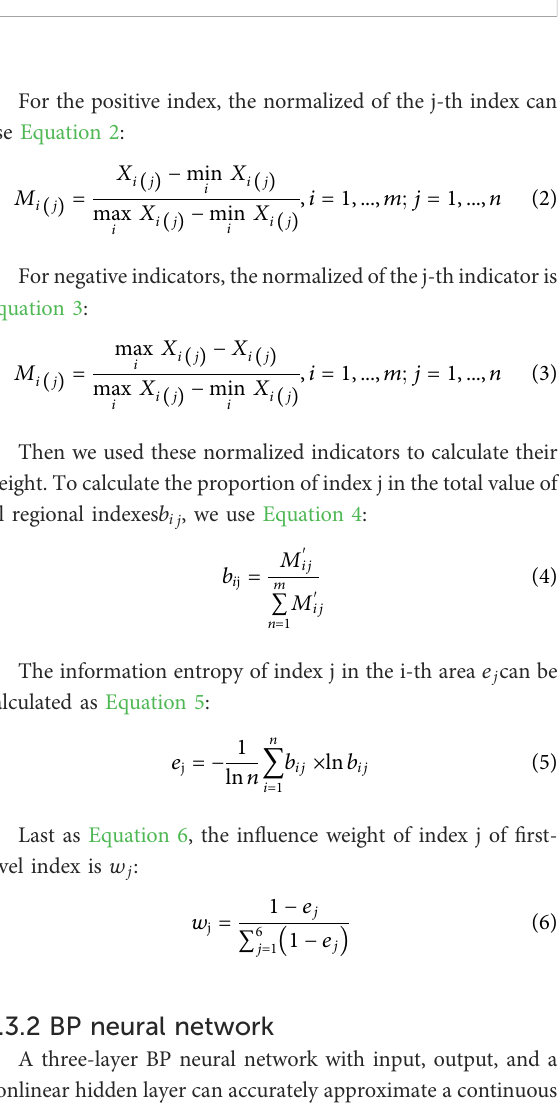
FIGURE 3 Three-layer BP neural network function